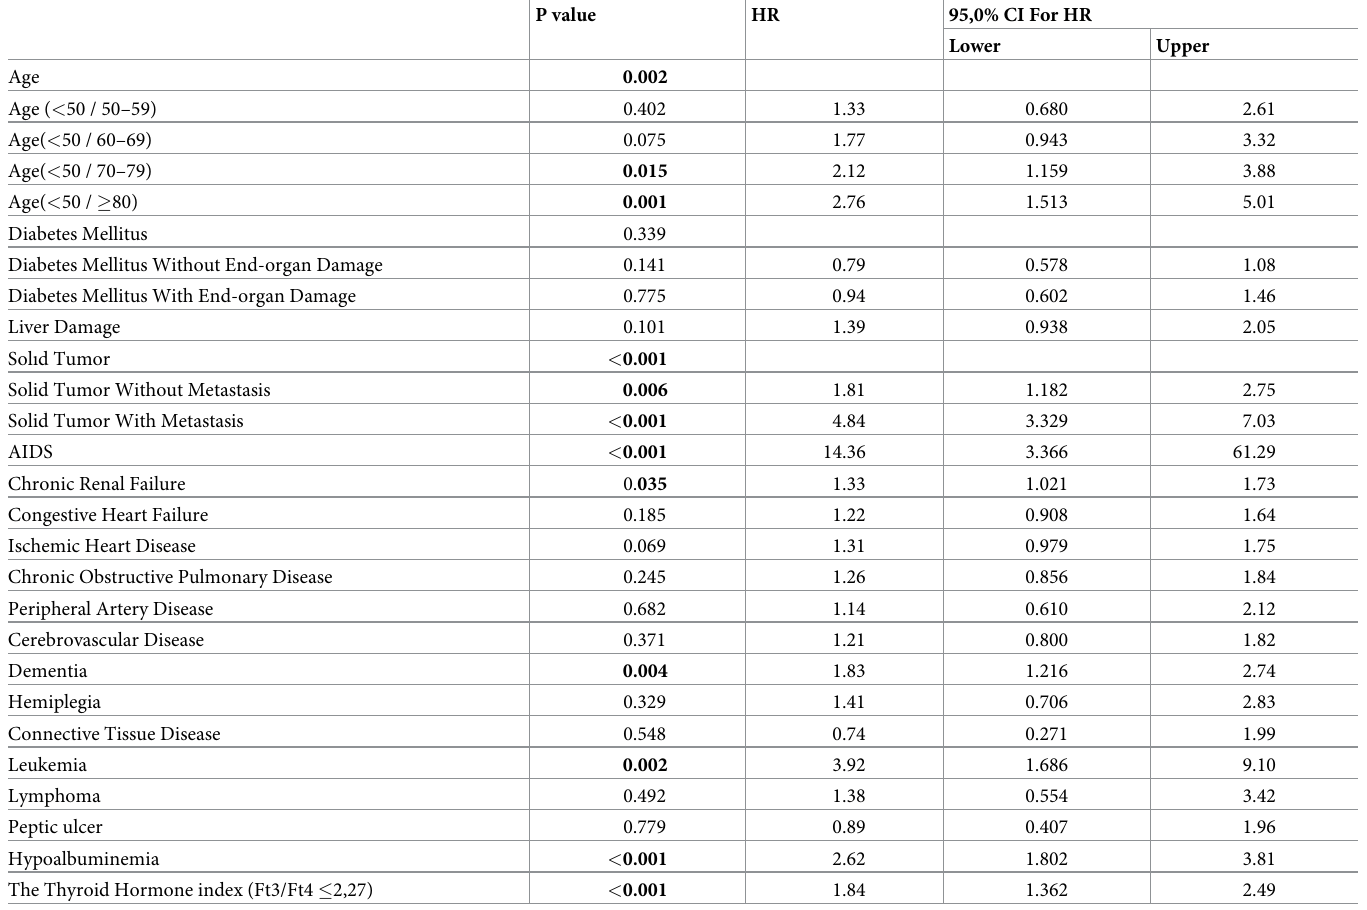
Table 3. Cox regression of comorbidities, albumin and thyroid hormone index in 3-month